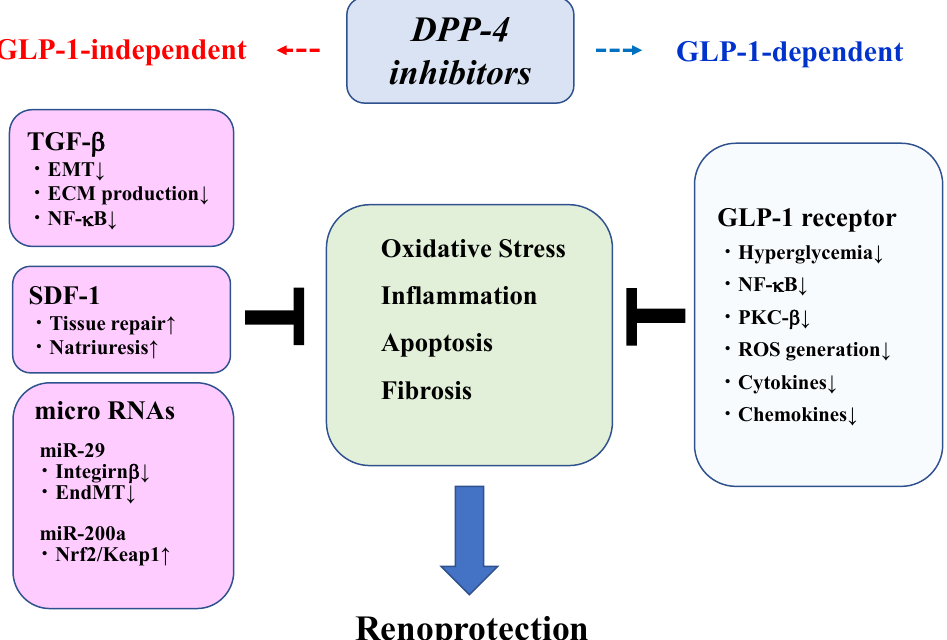
Figure 1. Renoprotective mechanisms of DPP-4 inhibitors. DPP-4 inhibitors exert renoprotection in both GLP-1-dependent and GLP-1-independent manners. The GLP-1-dependent pathway is mediated by GLP-1R. GLP-1-independent mechanisms are mediated by upregulating SDF-1 (DPP-4 substrate), micro RNAs such as miR-29 and miR-200a, and downregulating TGF- β